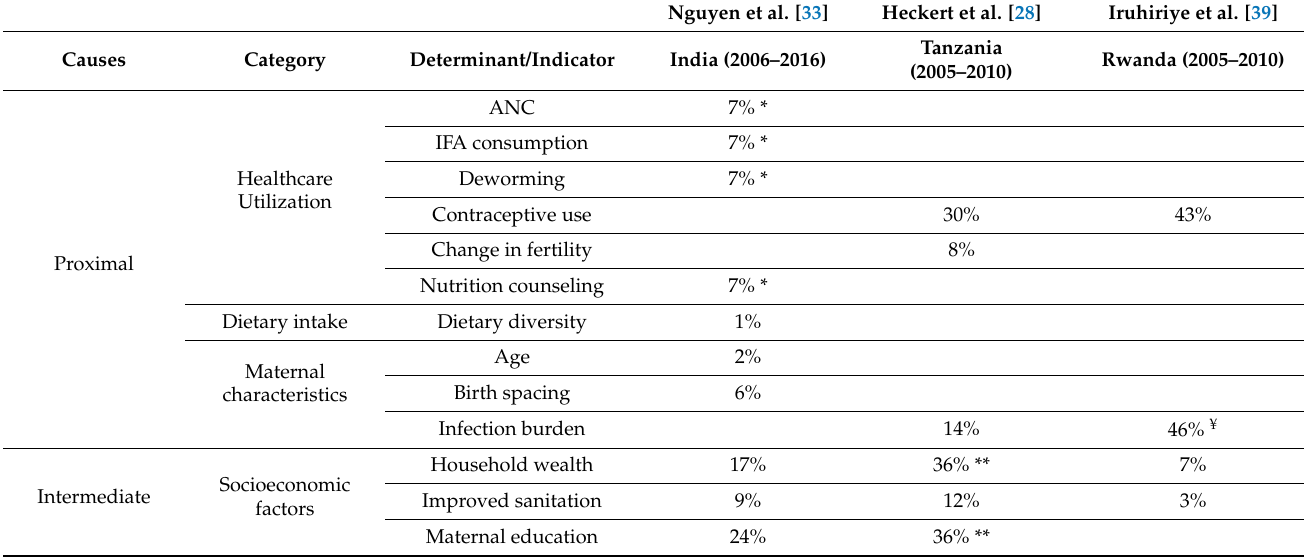
Table 1. Summary of changes in anemia prevalence, statistically explained by changes in anemia determinant indicators within regression decomposition